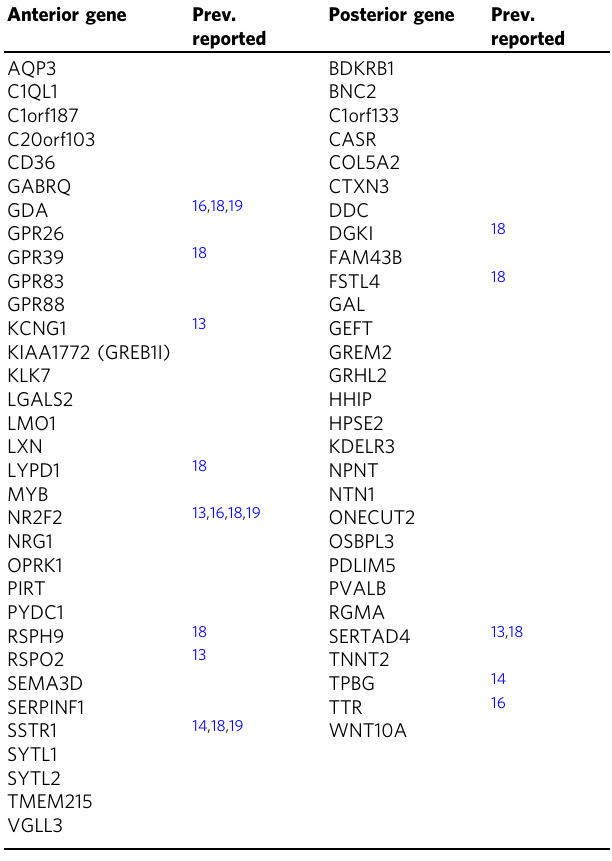
Table 1 The top anterior- and posterior-associated genes, respectively, identi fi ed by the LASSO-PCR model. Anterior gene Prev.